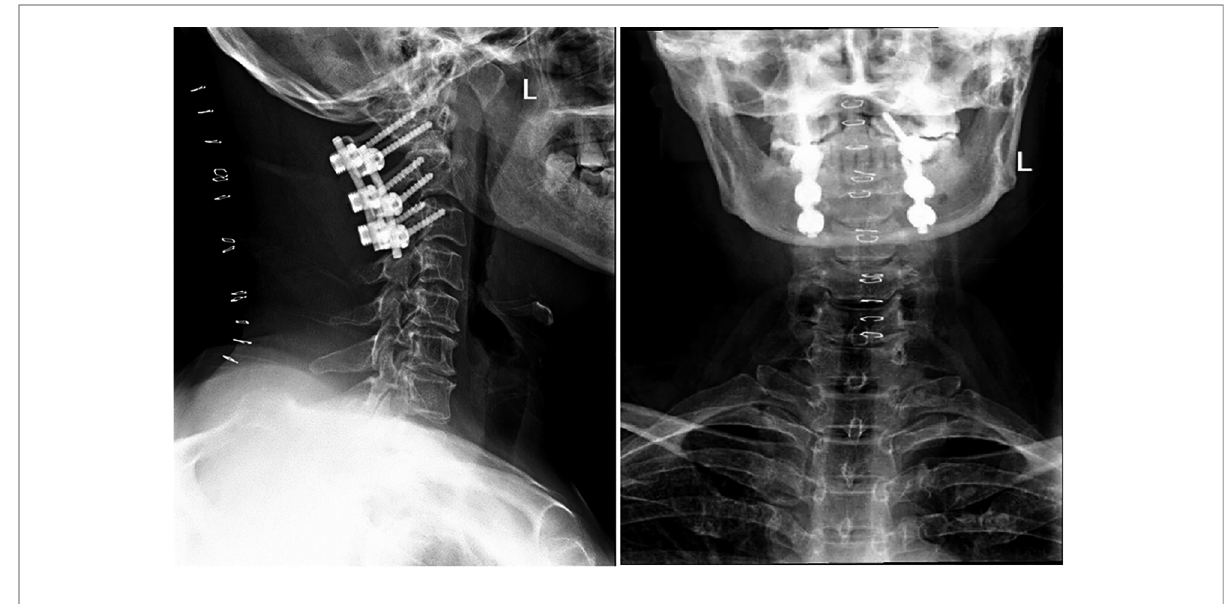
FIGURE 5 Postoperative lateral x-ray of cervical